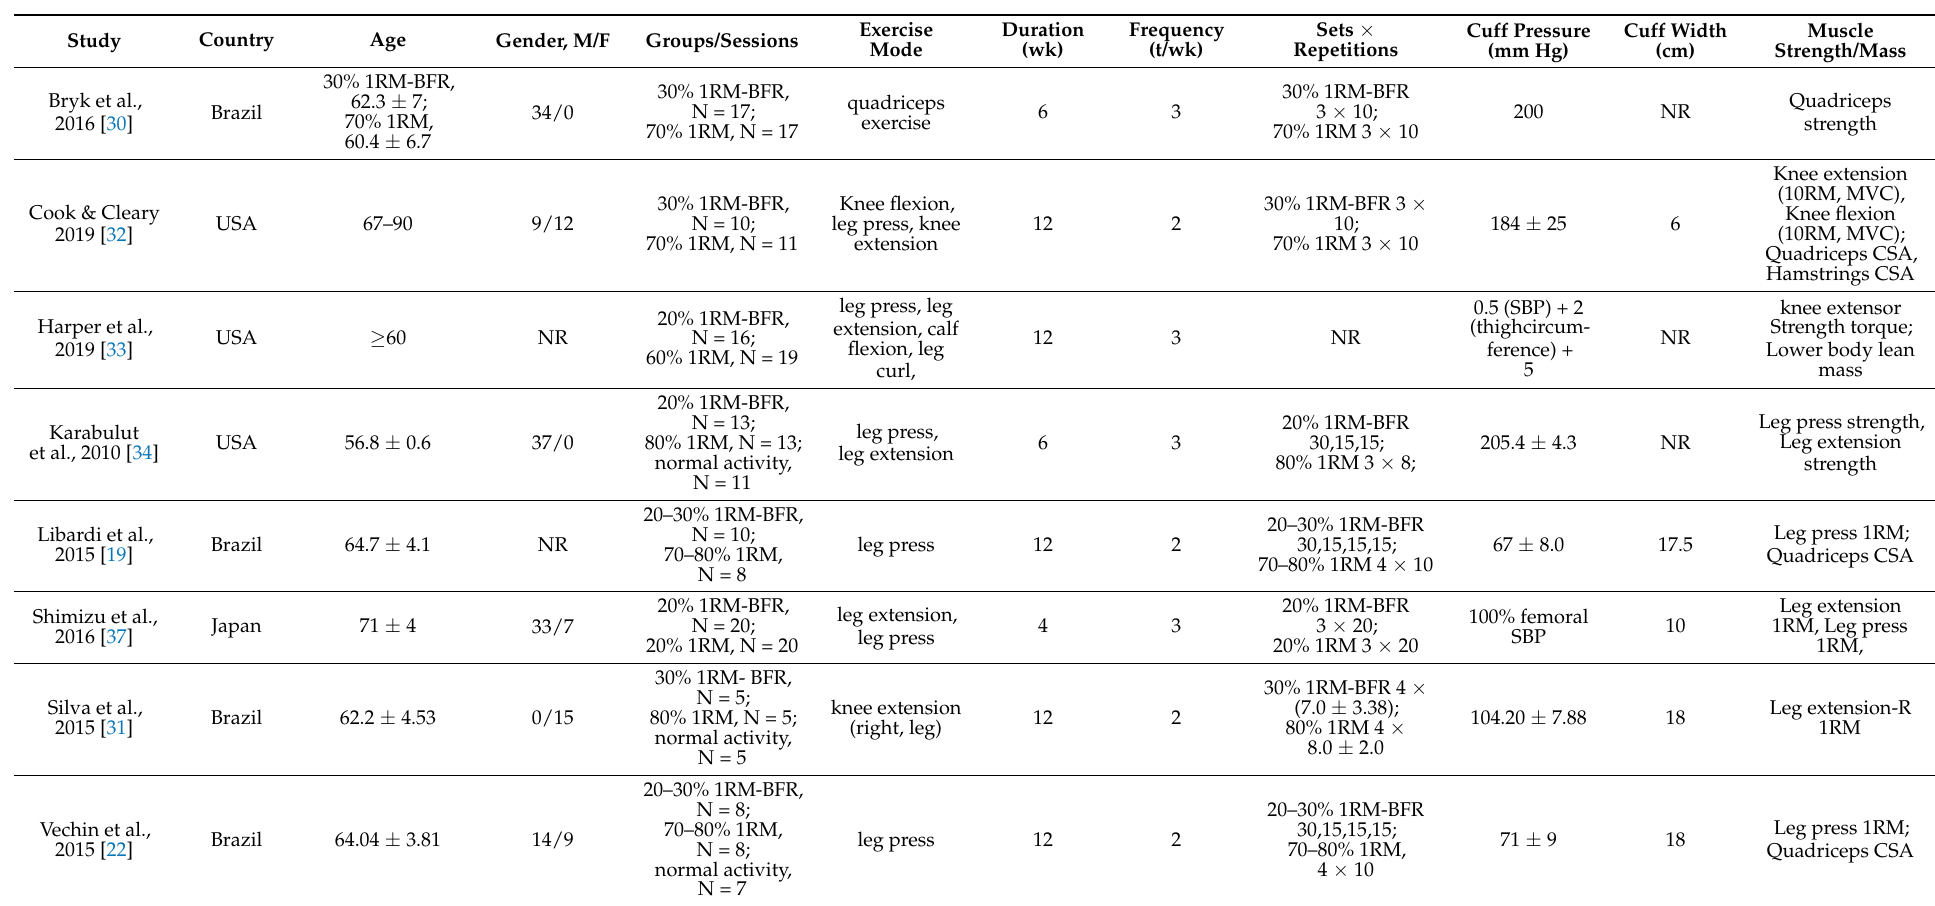
Table 1. Characteristics of the included